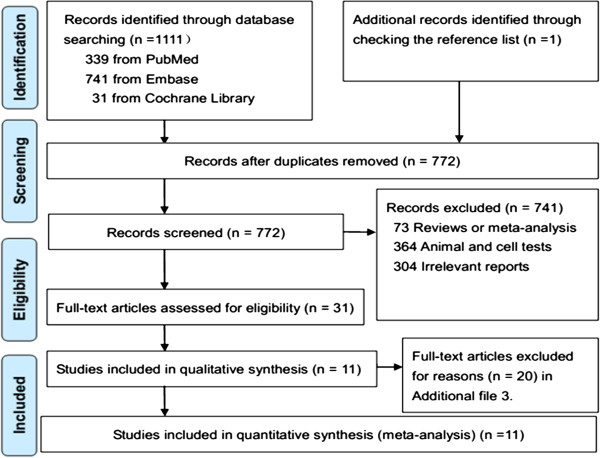
PRISMA flow diagram for included prospective studies.